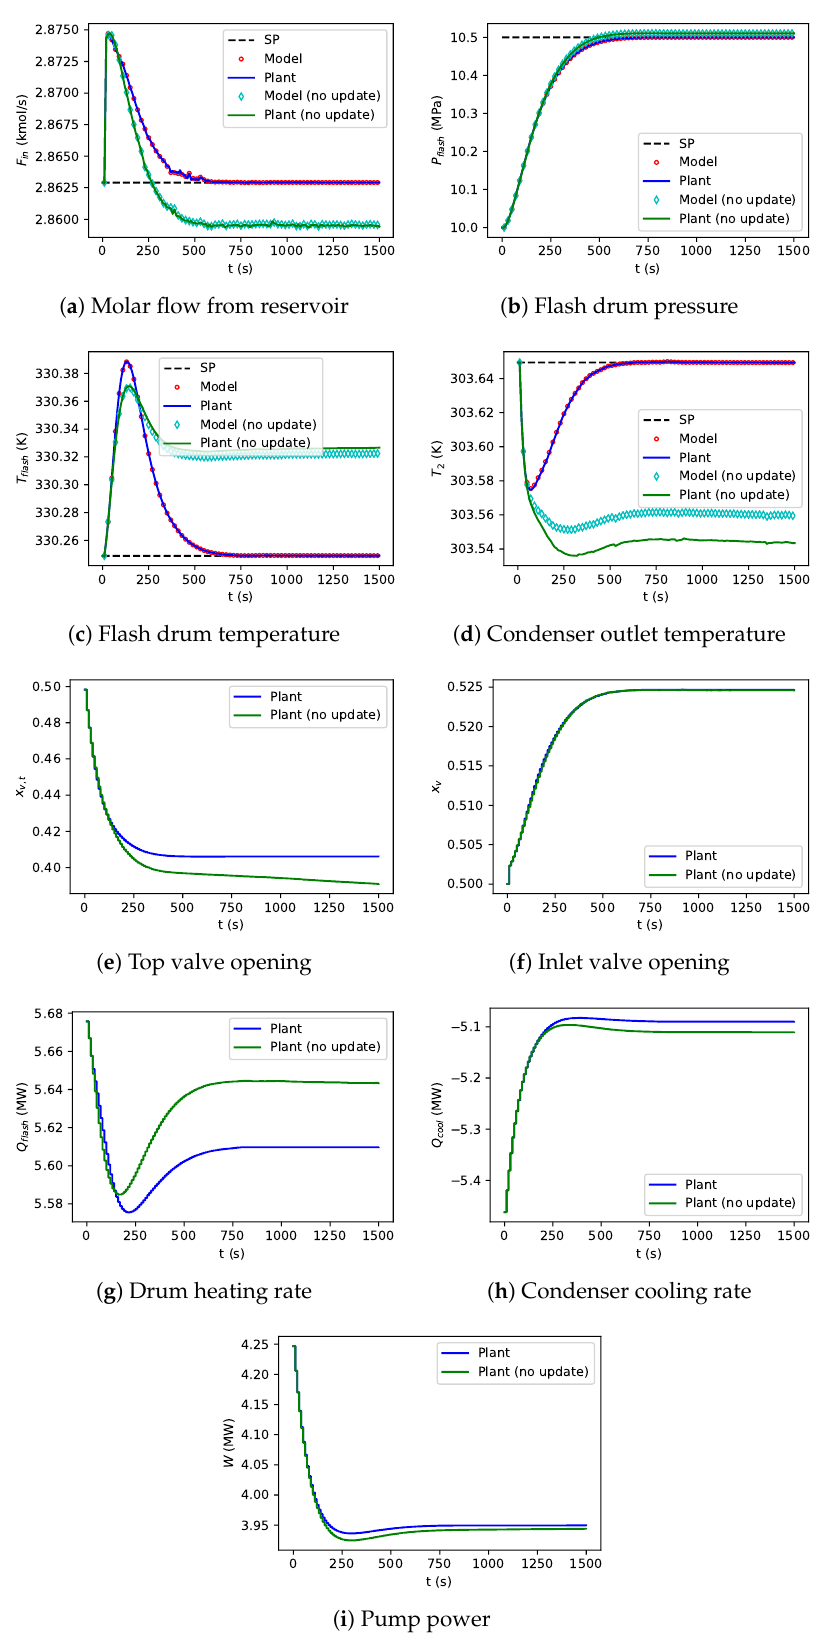
Figure 2. Closed-loop simulation of the flash pressure setpoint change: effect of the KF model